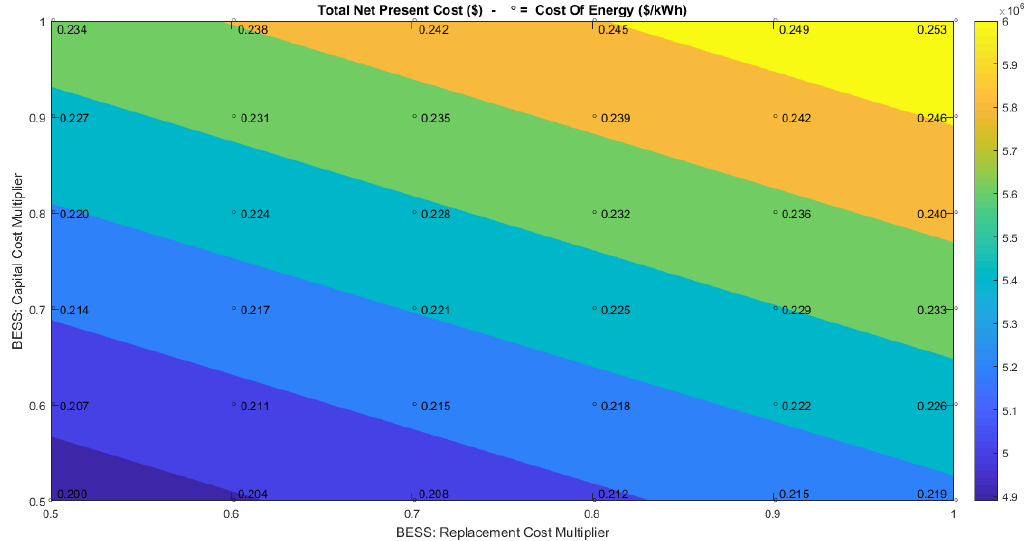
Figure 11. Effect on varying BESS capital and replacement costs multiplier on the COE and the NPC superimposed COE–surface NPC.